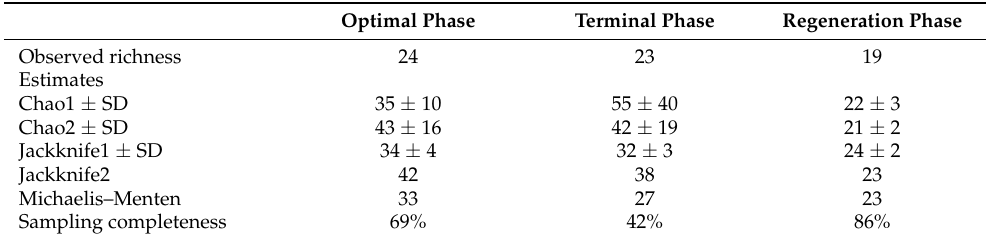
Table 5. Observed species richness and species richness estimates for spider assemblages of tree trunks in three developmental phases of oak–lime–hornbeam stand. Sampling completeness was calculated using Chao1 estimator.